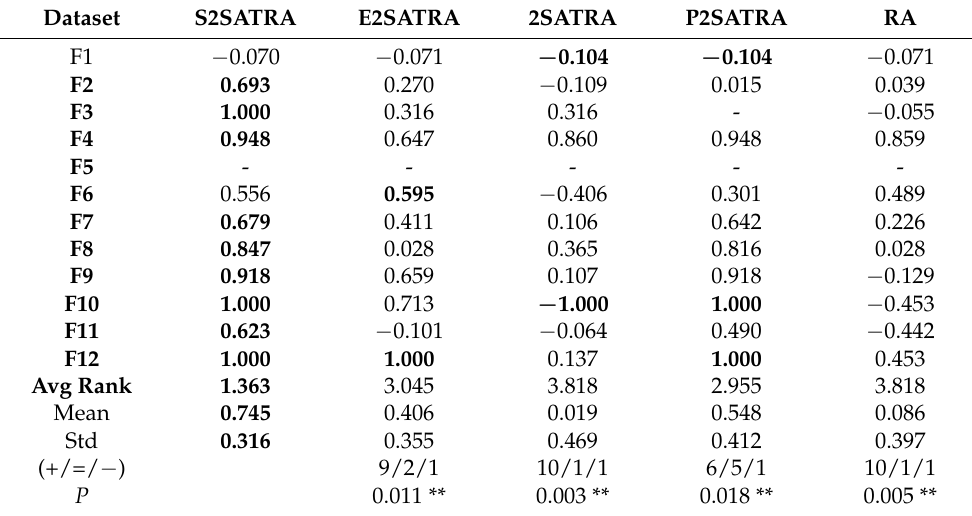
Table 13. MCC for all logic mining models. P is obtained from the paired Wilcoxon rank test and ** indicates the models with significant inferiority compared to the superiority